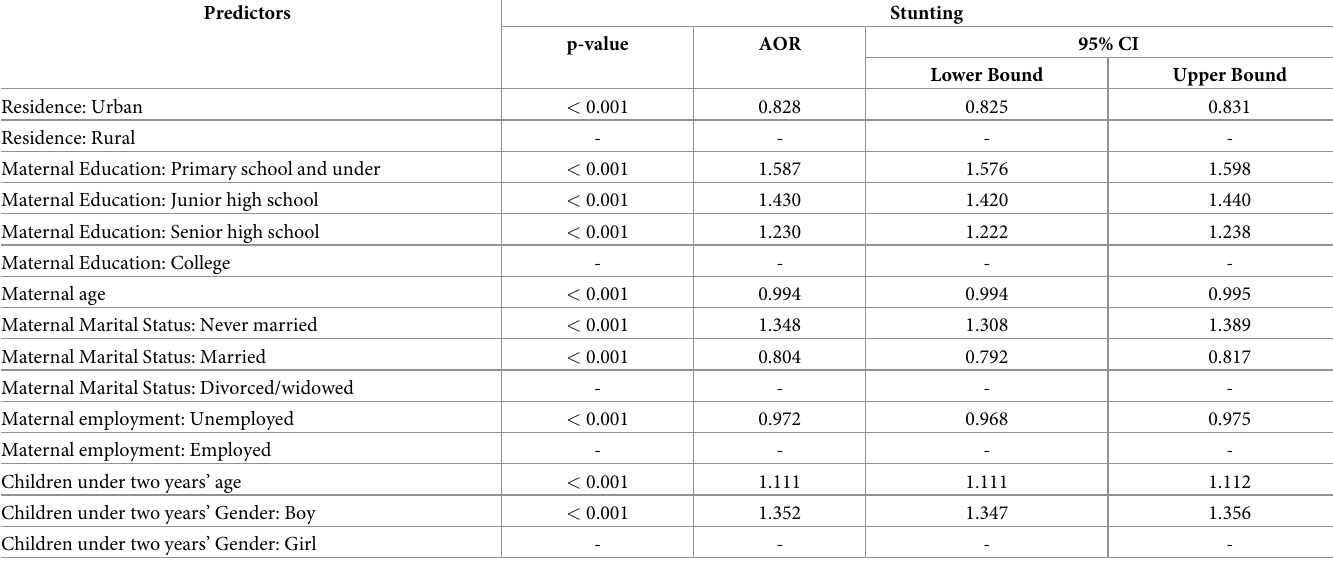
Table 3. Binary logistic regression of nutritional status of children under two years in Indonesia (n = 70,293). Predictors Stunting p-value AOR 95% CI Lower Bound Upper